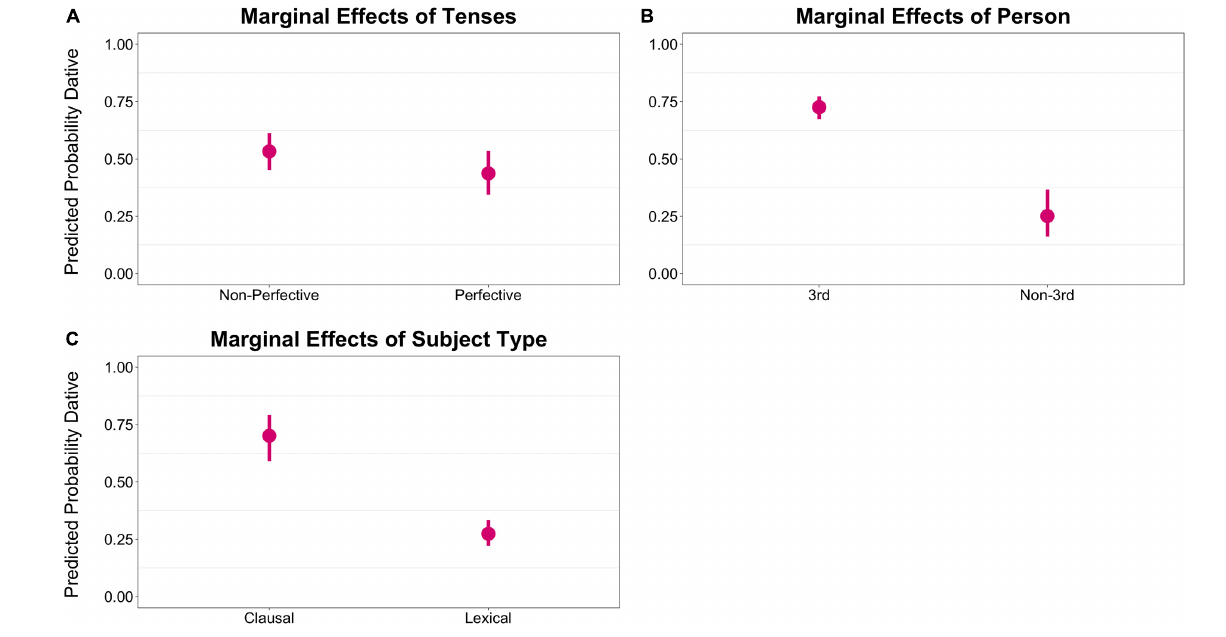
FIGURE 3 | Marginal effects of the single terms on clitic case. The y -axis represents the predicted probability of dative clitic. (A) shows the marginal effects of TENSE , (B) shows the effects of PERSON and (C) SUBJTYPE